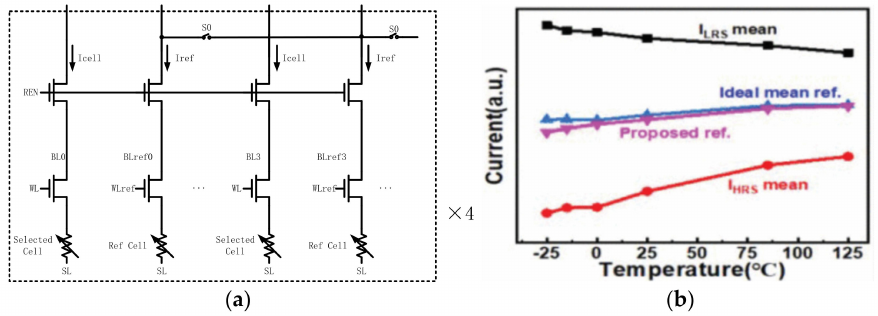
Figure 6. ( a ) The multiple dummy cells; ( b ) the read reference under different temperatures